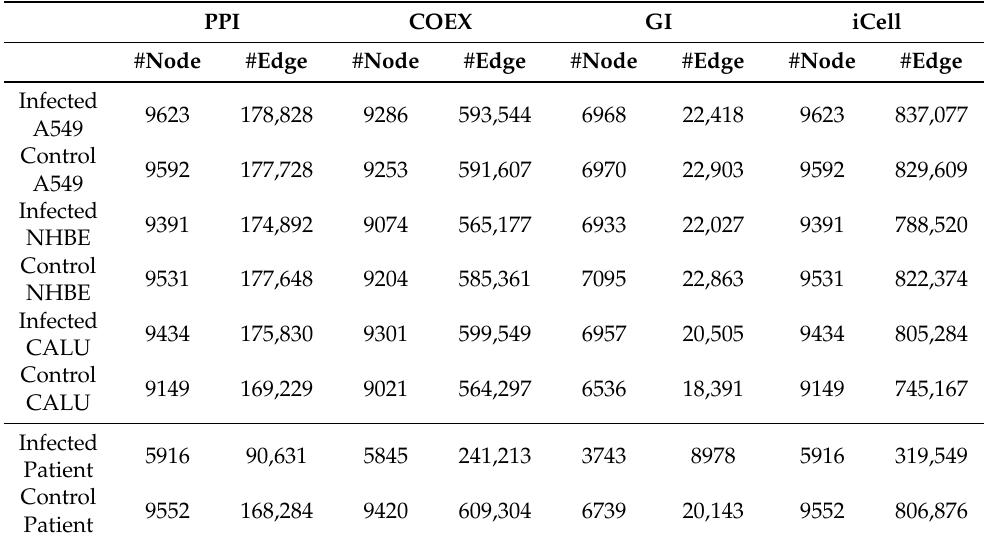
Table 1. Sizes of the networks. For each network, the table shows its numbers of nodes (column #Node) and edges (column